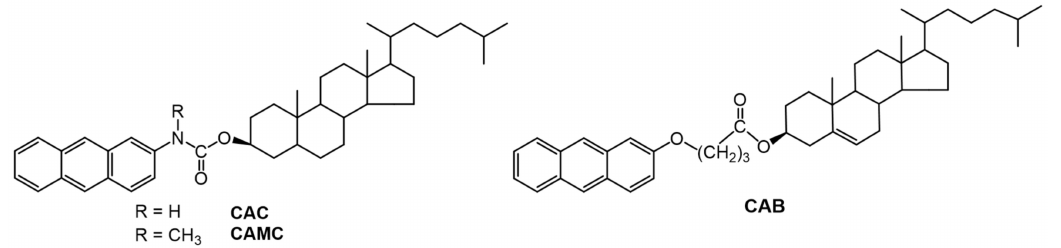
Figure 27. Molecular structures of CAC, CAMC and